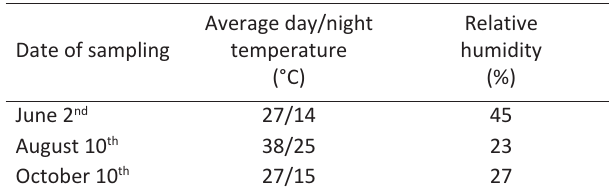
Table 1 ­ Average day and night temperature and relative humidity in the experiment region at the time of